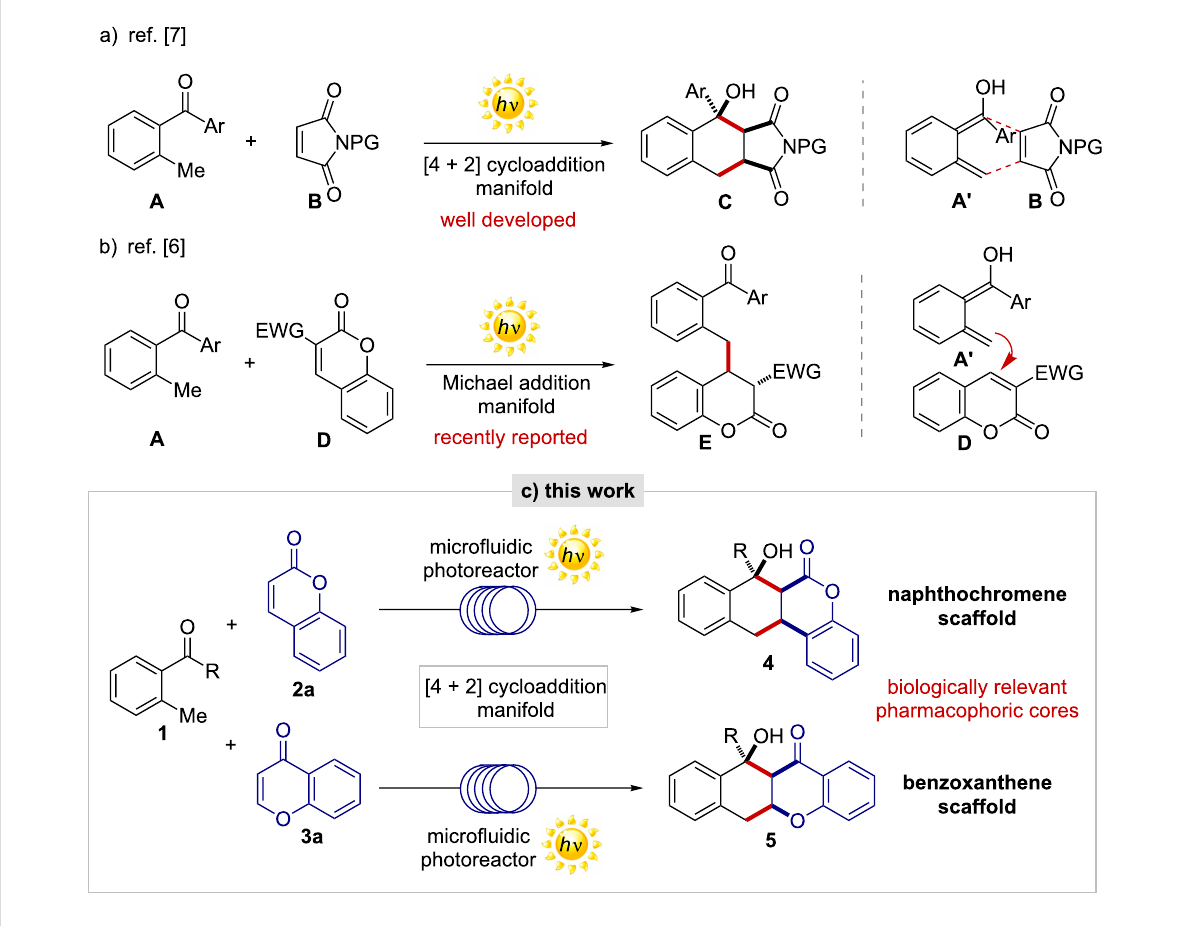
Figure 1: a) Light-driven reaction between 2-MBP A and maleimide B for the synthesis of C through a [4 + 2] cycloaddition manifold. b) Light-driven reaction between 2-MBP A and 3-substituted coumarin D for the synthesis of E through a Michael addition manifold. c) Light-driven reaction between 2-MBPs 1 and coumarin ( 2a ) or chromone ( 3a ) for the synthesis of privileged tetracyclic scaffolds 4 or 5 .